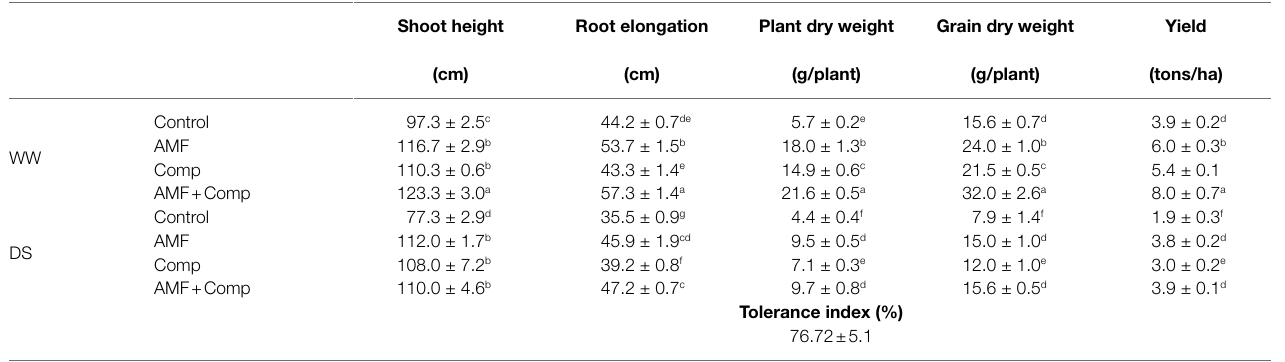
TABLE 2 | Growth performance, yield, and tolerance index of non-amended and non-inoculated quinoa (control), and quinoa inoculated with arbuscular mycorrhizal fungi (AMF) and/or amended with compost (Comp) subjected to different water regimes (WW; well-watered or DS: drought stress). Shoot